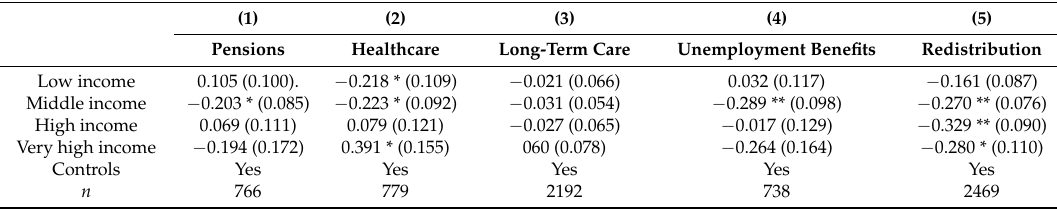
Table 4. Marginal effect of the tax constraint across income